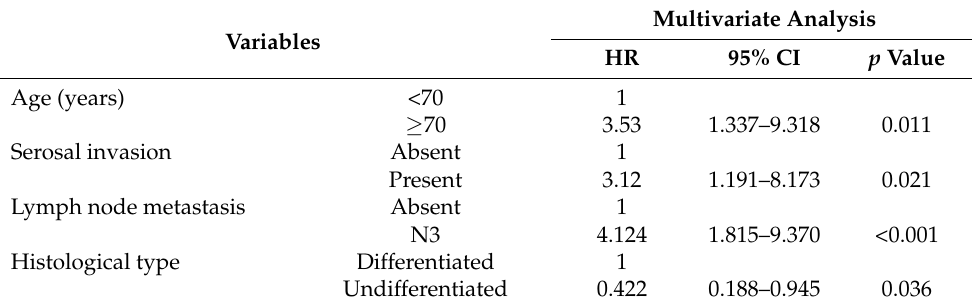
Figure 3. Survival curves for overall survival in patients without inflammation. ( a ) According to malnutrition, ( b ) according to severity of malnutrition. Table 3. Prognostic factors for overall survival in patients with